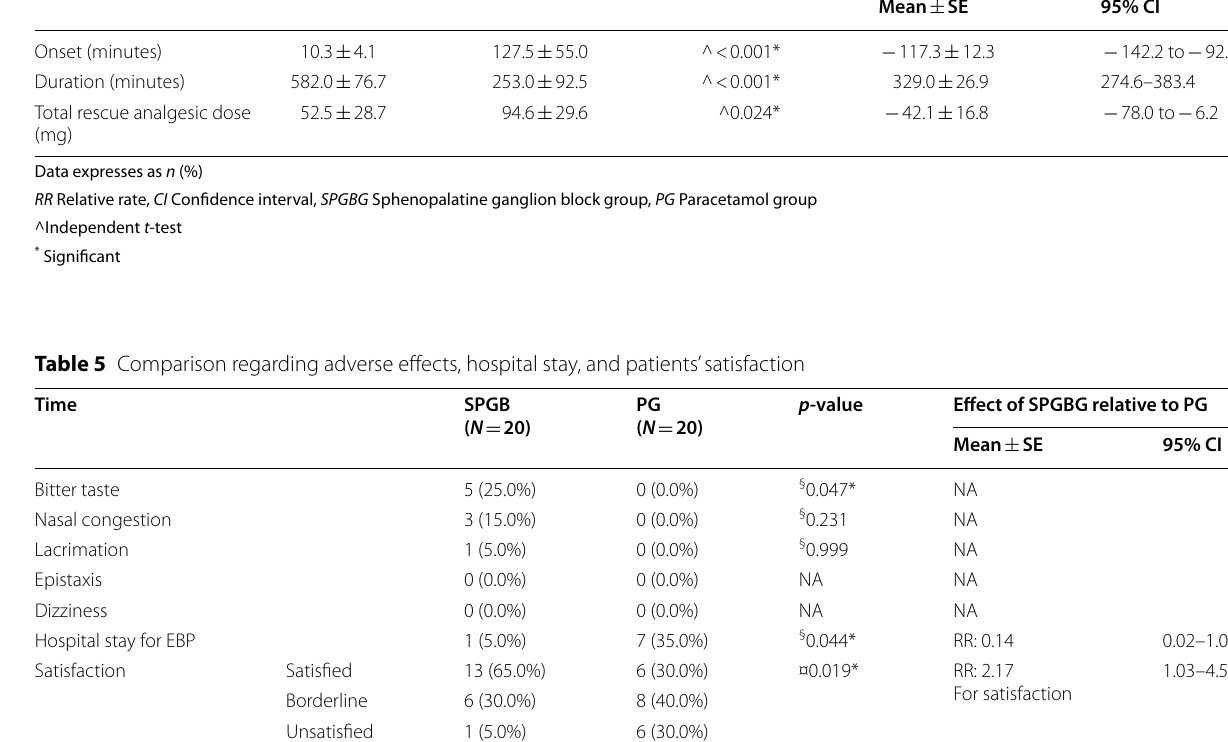
Data expresses as n (%). NA Not applicable. § Fisher’s exact test. ¤Linear by linear association RR Relative rate, CI confidence interval, SPGBG Sphenopalatine ganglion block group, PG Paracetamol group, EBP Epidural blood patch